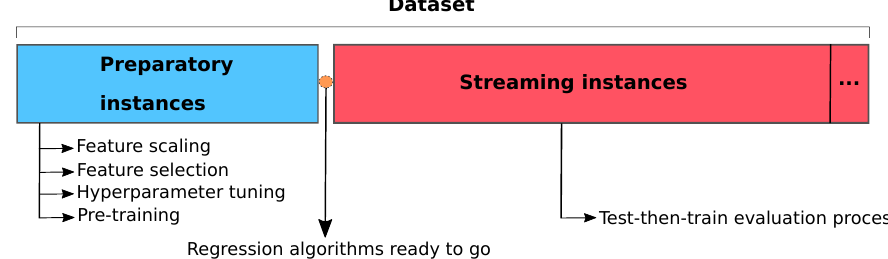
Figure 2. Scheme of the SL process of this